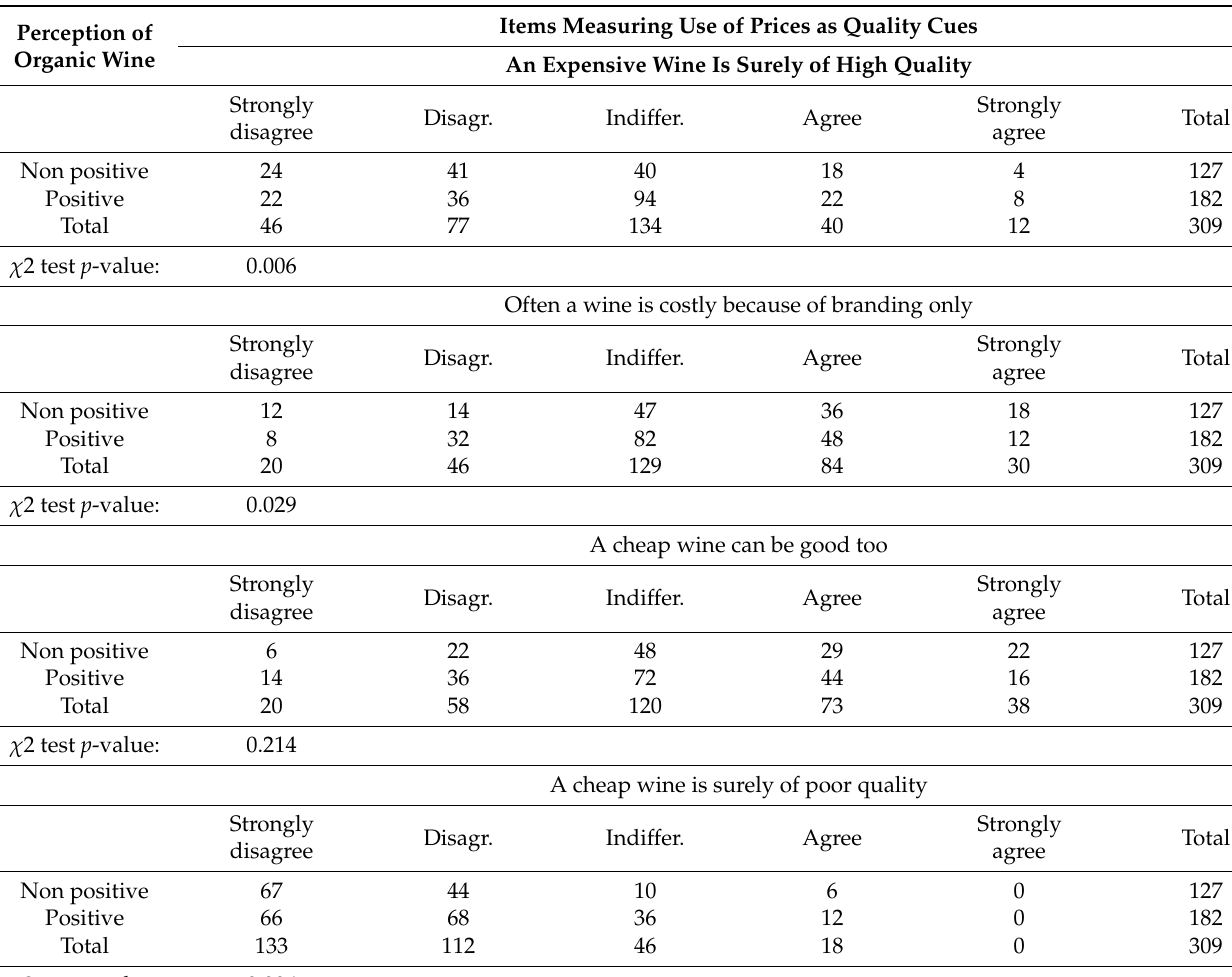
Table 2. Association between variables measuring use of prices as quality cues and organic wine perception.